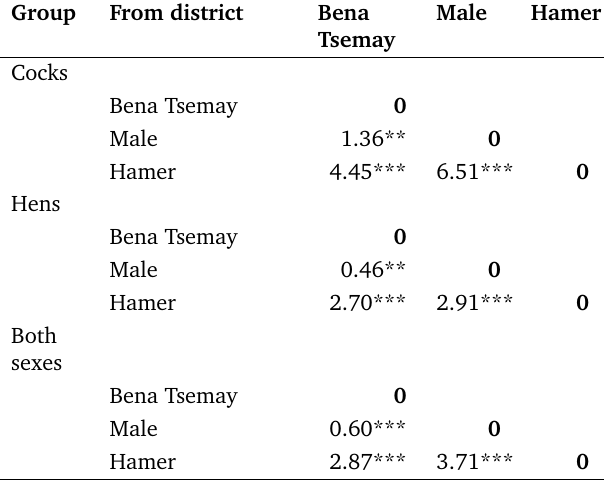
Table 12. Squared Mahalanobis distance between districts; output of the multivariate analysis calculated using the quantitative measurements. *** indicates significance of the distance calculations at p <